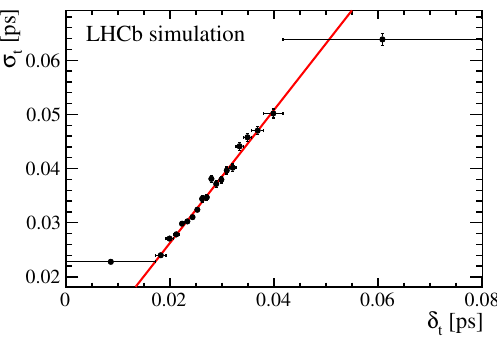
Figure 6 . Per-event decay-time resolution, (cid:27) t , versus the estimated per-event decay-time uncer- tainty, (cid:14) t , obtained from simulated samples containing both vector-vector resonant B 0 and phase-space B 0 K + (cid:25) (cid:0) K (cid:0) (cid:25) + events. s !